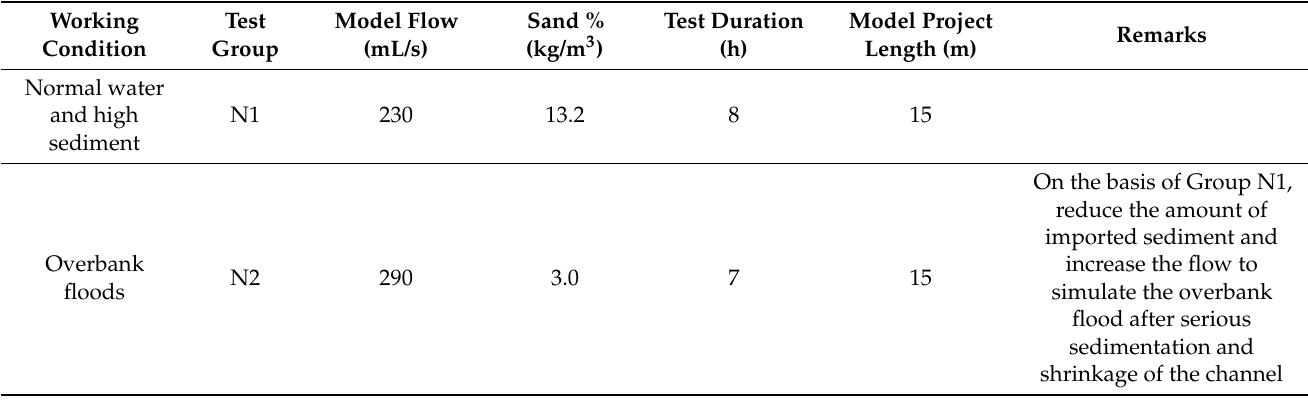
Table 1. Test conditions of each